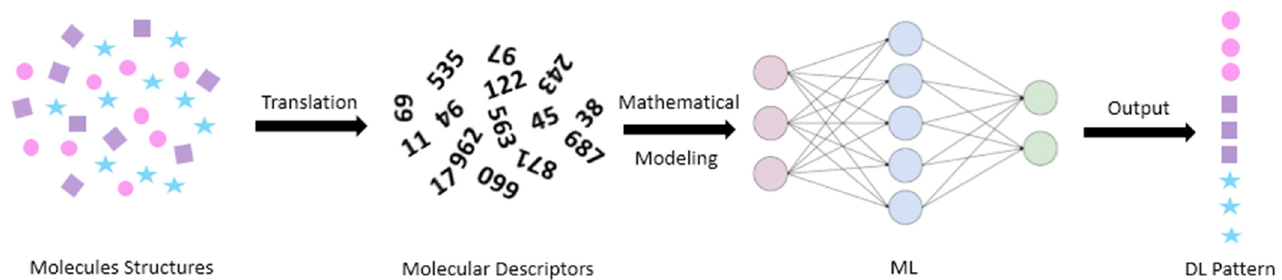
Figure 4. Molecular descriptors and machine learning in drug loading prediction.